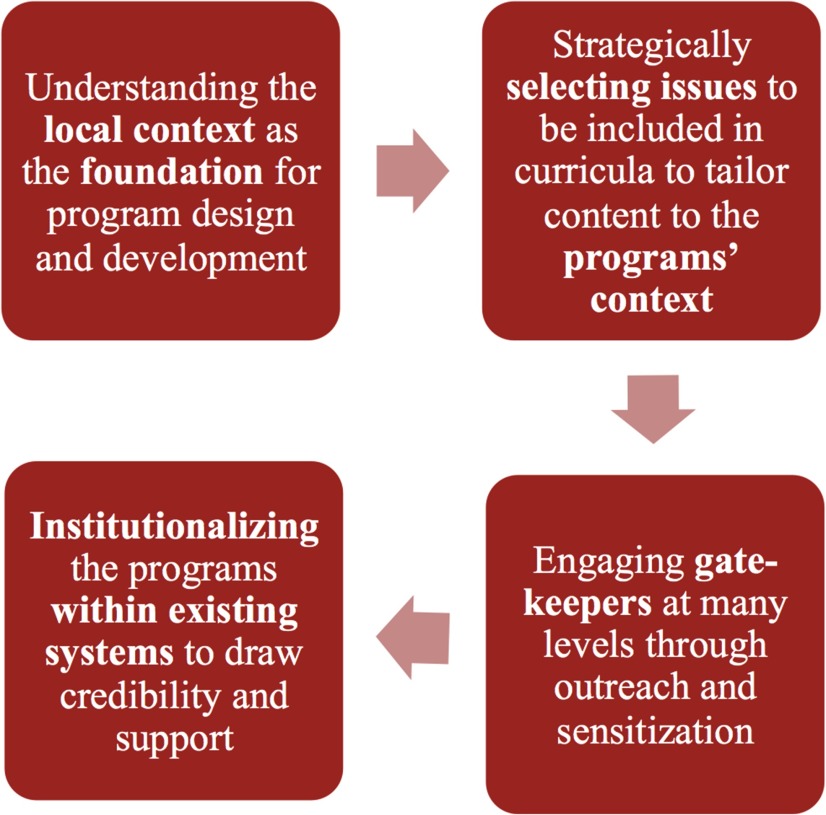
Strategies Used by Aahung and Rutgers Pakistan to Build Community Support for Their Sexuality Education Programs